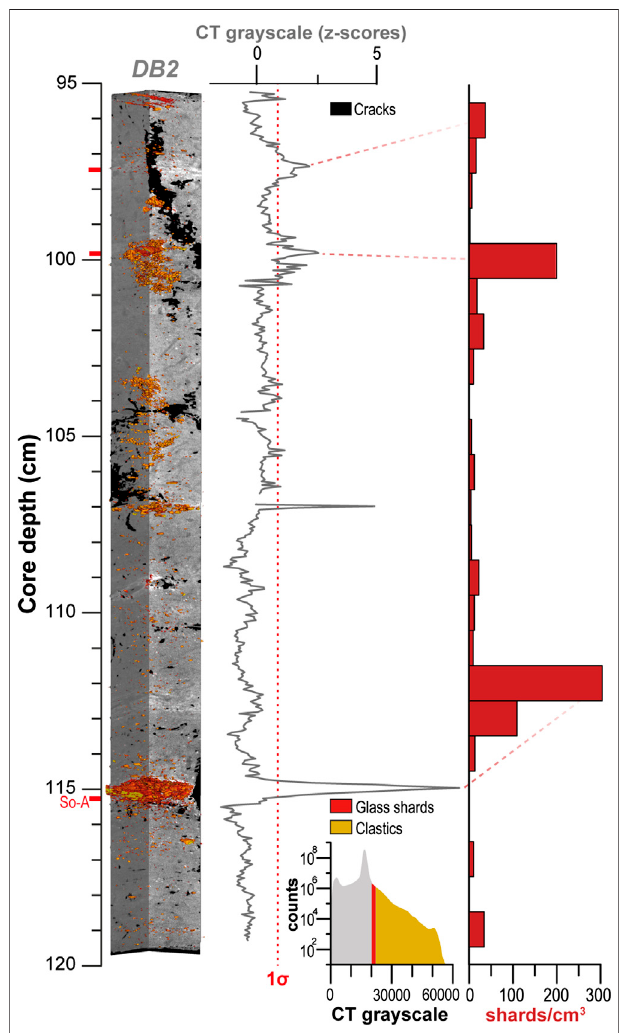
FIGURE 6 | CT scans (2-D orthoslices and 3-D representations) and 1 cm resolution manual shard ( > 20 μ m) counts of the analyzed 95 – 120 cm section of peat core DB-2 with red bars (Oppedal, van der Bilt, Balascio et al., 2018; Conventionally Analyzed Natural Archives section). The histogram highlights the grayscale value distribution of rhyolitic glass (red) and heavier clastic material (orange) dispersed throughout the core (including partial volume effects). We also highlight the color of cracks (black). Down-core CT grayscale variability is plotted as standardized (z-score) values, and the red stippled line shows the 1 σ range of z-scores. Red dashes indicate horizons detected in both scans and counts.